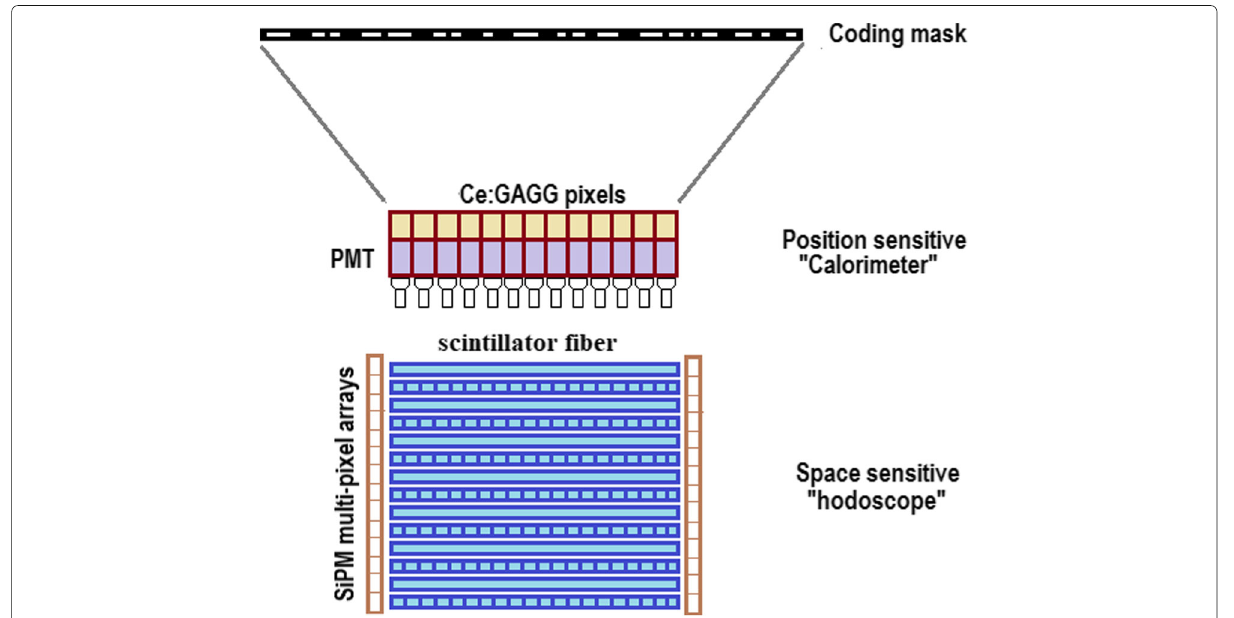
Fig. 8 The design of tracking gamma spectrometer